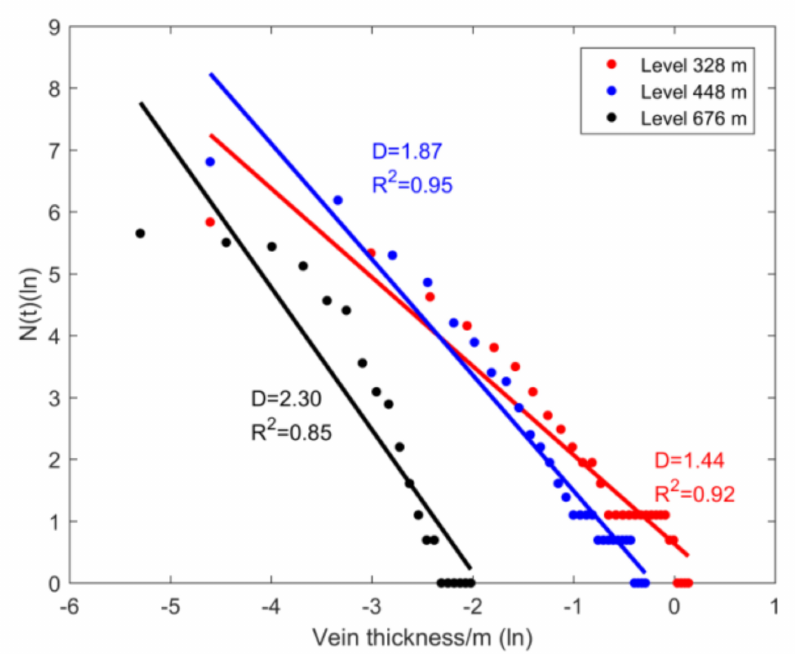
Figure 5. Log-log plots of the cumulative number N ( t ) of veins against vein thickness at different levels. N ( t ) is the number of veins whose vein thickness is larger than t , D is the fractal dimension (the slope of the fitted line multiplied by − 1), and R 2 is the corresponding fitting degree. The slope of the fitted line is − D. The vein thickness and N ( t ) have been transformed by natural logarithm.